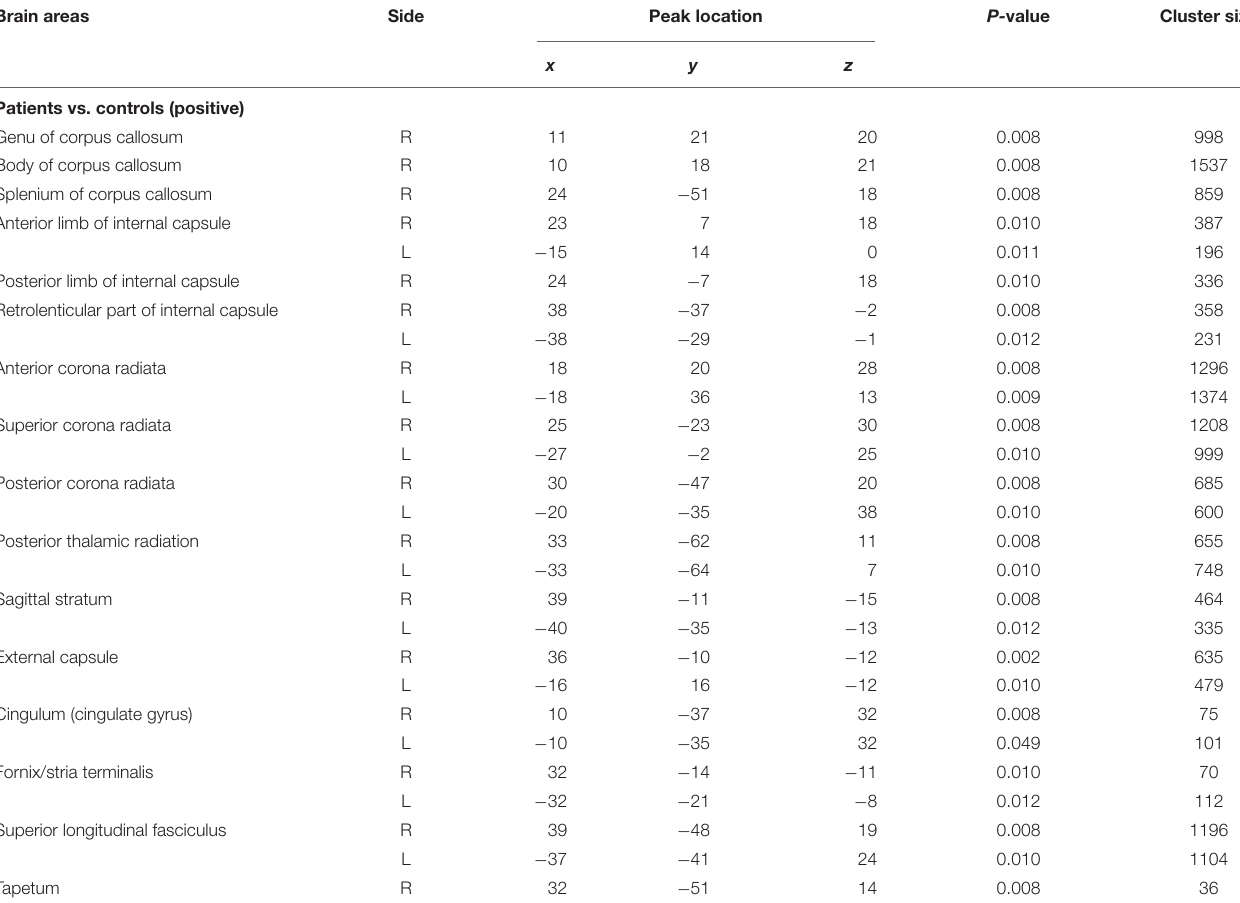
TABLE 4 | Comparisons of MD maps between patients with anti-LGI1 encephalitis and normal controls. Brain areas Side Peak